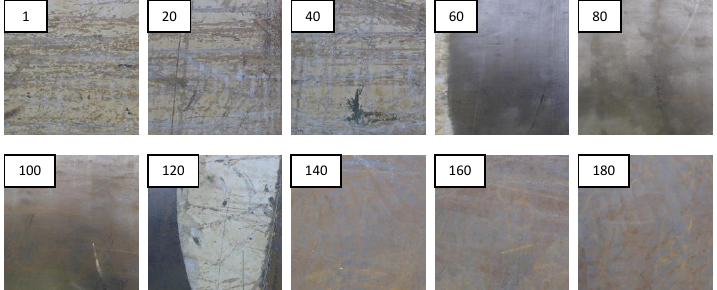
Figure 10. The image frames captured during the robot’s run with an interval of 20 frames. The corresponding frame number annotated in each